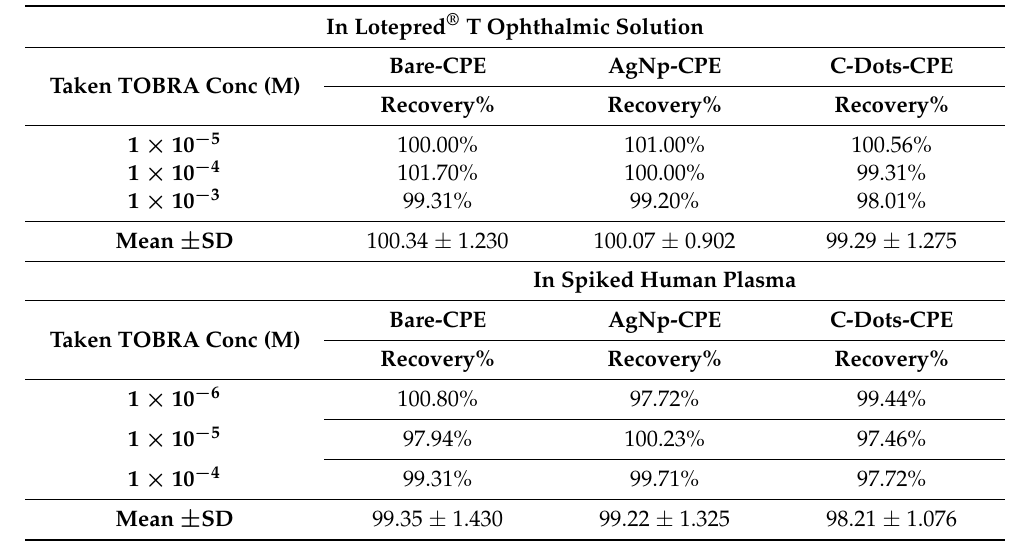
Table 4. Determination of TOBRA in Lotepred ® T ophthalmic solution and spiked human plasma by the proposed electrodes.